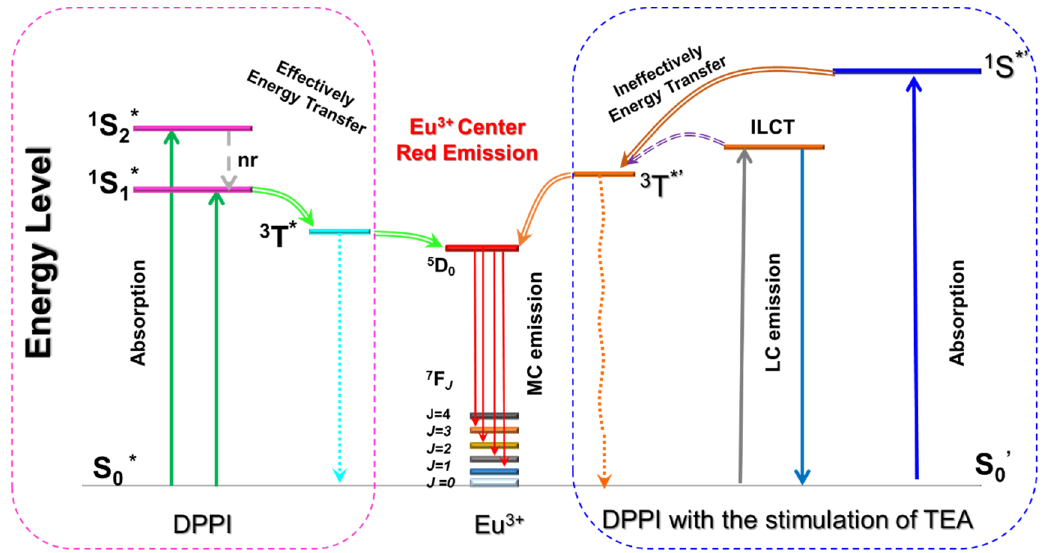
Figure 3. Schematic representation of the energy states and emission processes in the Eu 3+ -complex with the simulation of TEA or not. (*excited state; ’ differentiate the energy states before and after added TEA; LC, ligand-centered; MC, metal-centered; ILCT, intra-ligand charge transfer; S, singlet state; T, triplet state, ET, energy transfer.).